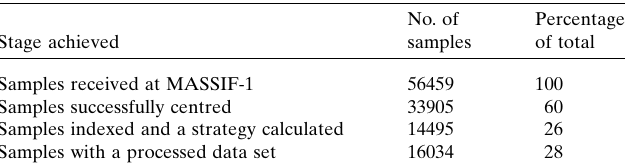
Table 1 The fate of crystals sent to